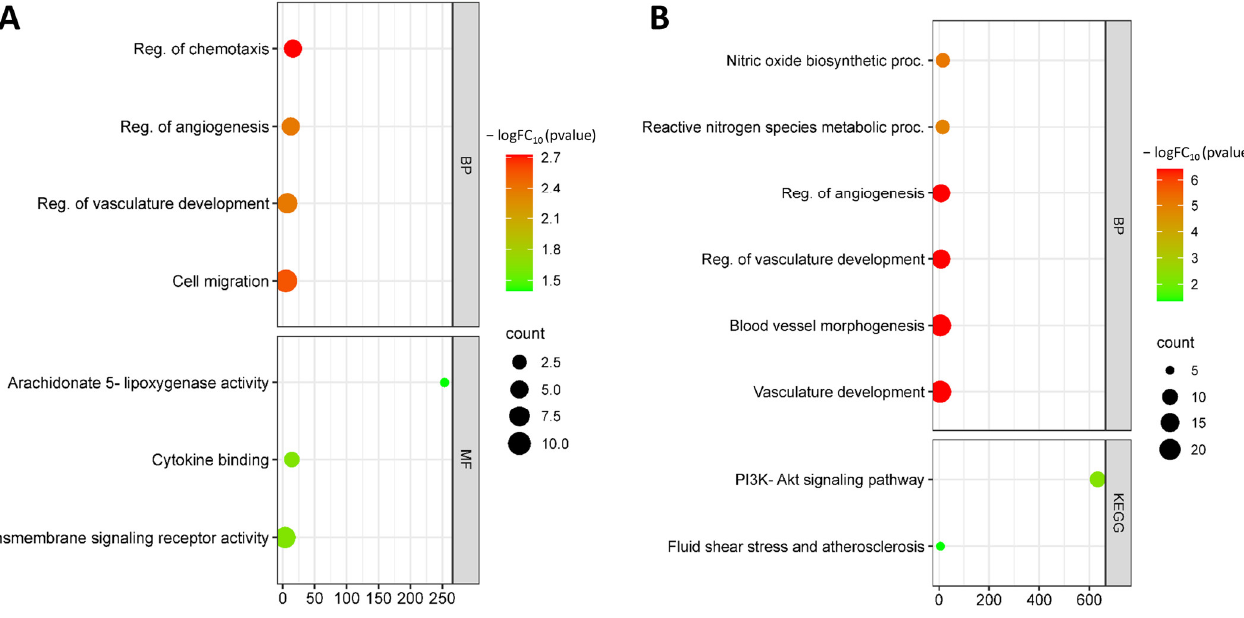
Figure 2. Functional enrichment of up-regulated DEGs ( A ) and down-regulated DEGs ( B ) from the GSE103672 dataset.